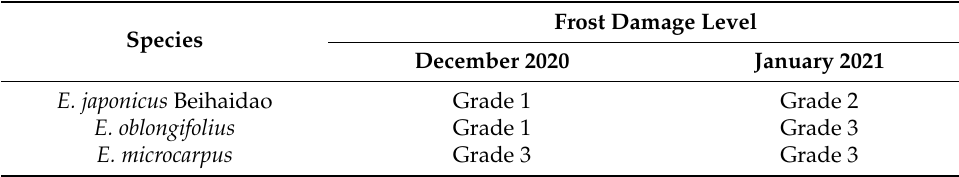
Table 2. Frost damage levels of three Euonymus species.